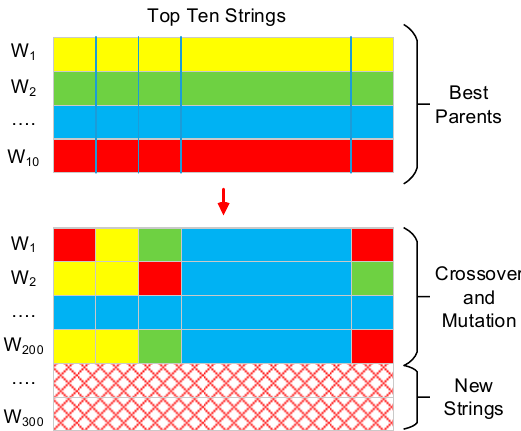
Figure 5. Genetic algorithm.